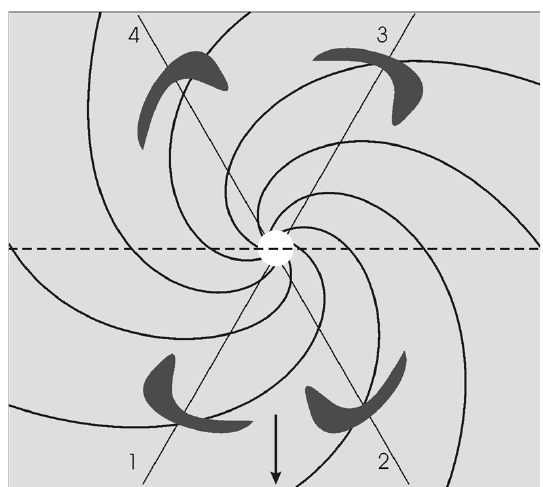
Fig. 7. Sketch illustrating possible mechanism of east-west asym- metry generation. The small circle at the centre marks the Sun. The arrow at the bottom indicates a direction to the observer. The plane of the sky is marked by the horizontal dashed line. Hypothetical shape of CME front (thick lines), deformed by the solar magnetic field, in four different positions equidistant from the plane of the sky, is shown. The straight thin lines mark directions of CME prop- agation. Note that the fronts shown are asymmetric in the ecliptic plane (plane of the figure). The observer can see CME in the plane of the sky (perpendicular to the plane of the figure), so he will not observe this asymmetry at